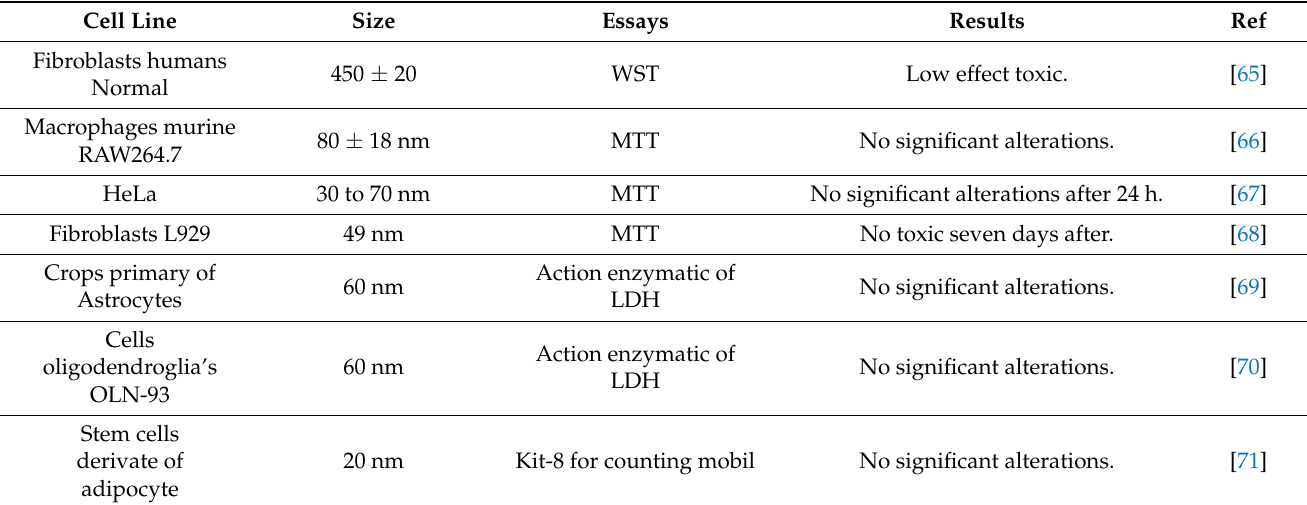
Table 4. Cell viability associated with the size of the polymeric